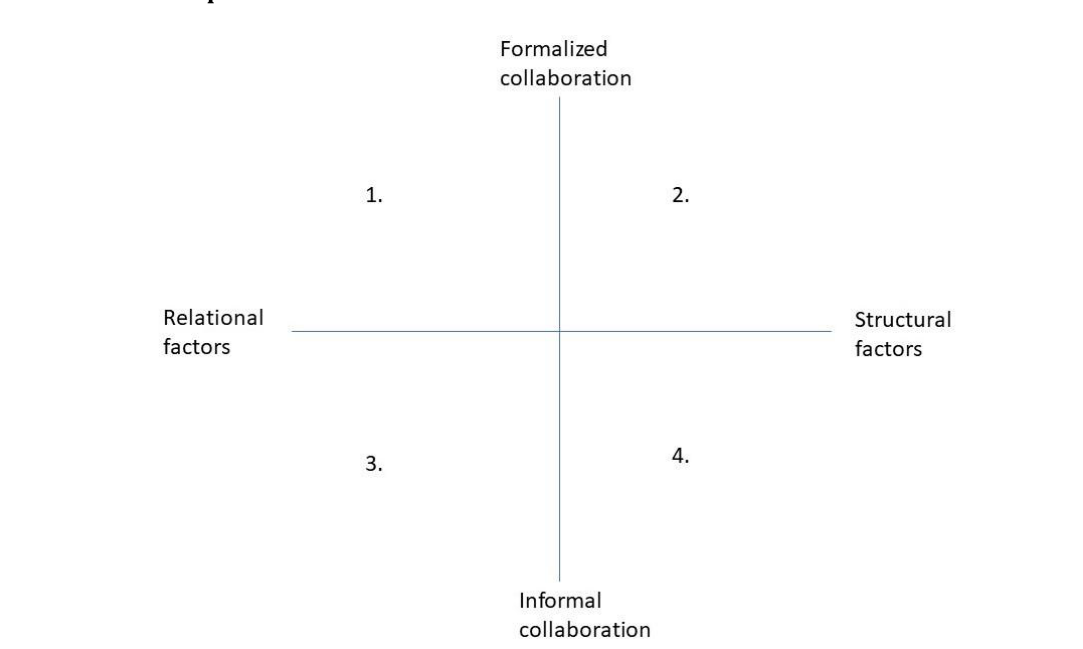
Figure 2. Tentative conceptual model of factors that influence